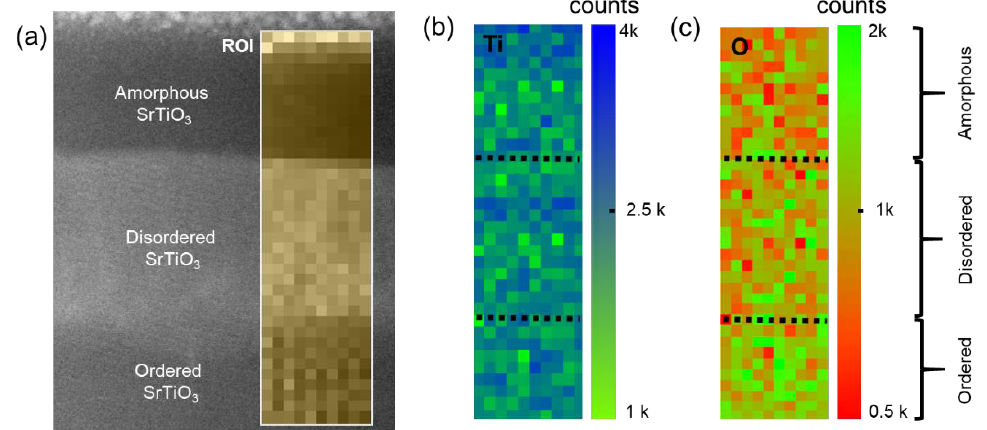
Figure 3. ( a ) Shows an ADF image with an overlaid region of interest (ROI) taken simultaneously to obtain an EELS map. ( b , c ) Corresponding EELS color maps for Ti and O are obtained over the ordered-amorphous